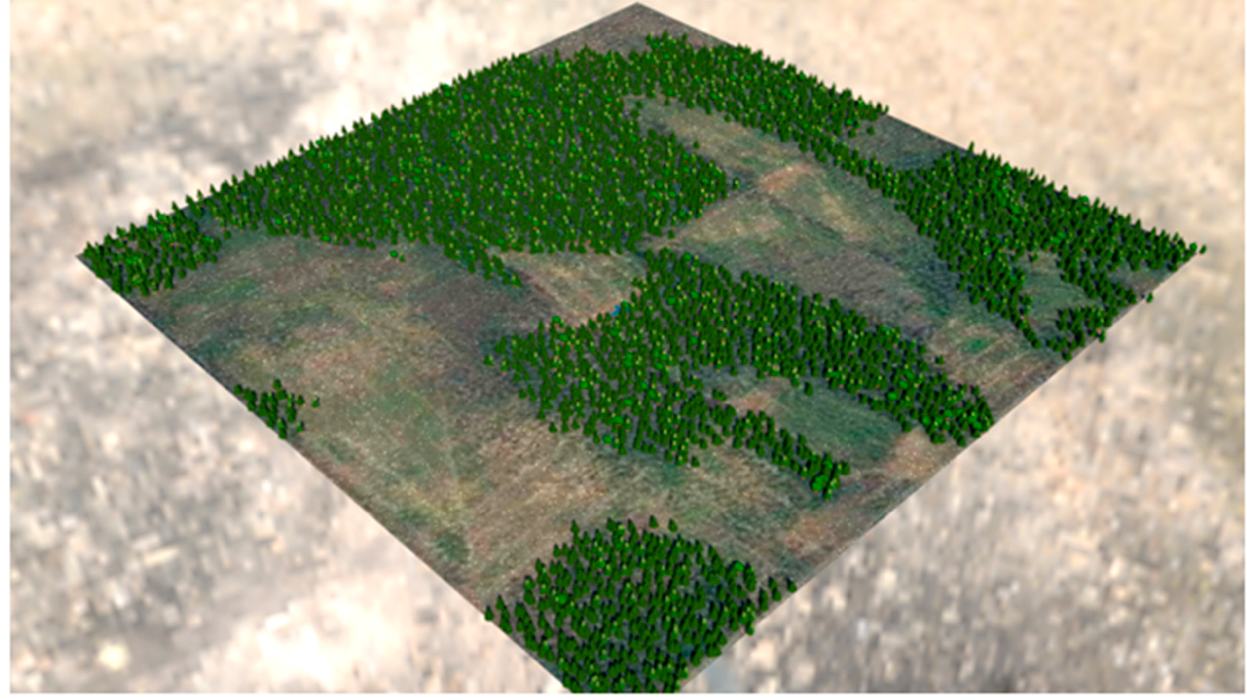
Figure 6. Final integration of data.